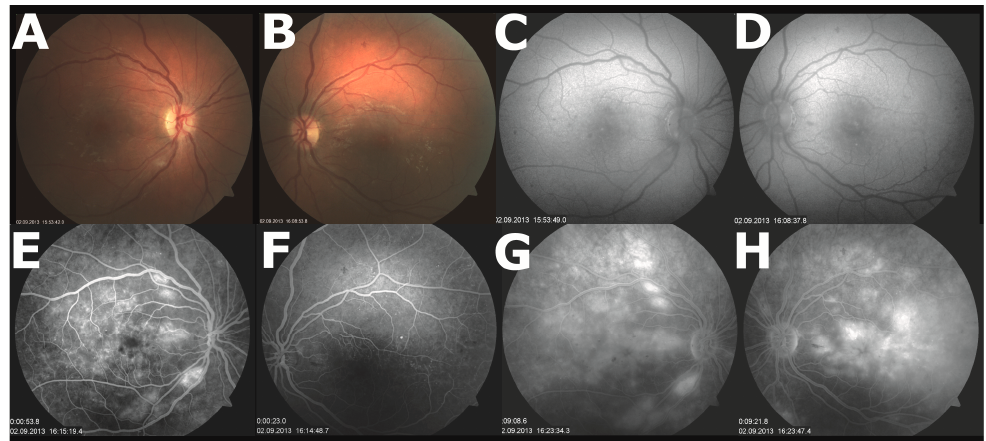
Figure 1. Results of the fundus photography and fluorescein angiography examinations. ( A , B ) Fundus photography of the right eye ( A ) revealed one small cotton-wool spot over the right inferior arcade and few intraretinal dot-and-blot hemorrhages temporal to the fovea centralis, but no hard exudates. In the left eye ( B ), it displayed few dot-and-blot hemorrhages in the superior and temporal area. Findings were in agreement with mild non-proliferative diabetic retinopathy; ( C , D ) Red free fundus photography allowed better visualization of the dot-and-blot hemorrhages in the right ( C ) and left ( D ) eye; ( E , F ) Early-phase fluorescein angiography of the right eye ( E ) showed diffuse macular hyperfluorescence and few microaneurysms. In the left eye ( F ), few microaneurysms were visible and it was not possible to assess the perifoveal arcade; ( G , H ) Late-phase fluorescein angiography reveals diffuse cystoid macular edema the right ( G ) and more pronounced in the left eye ( H ).